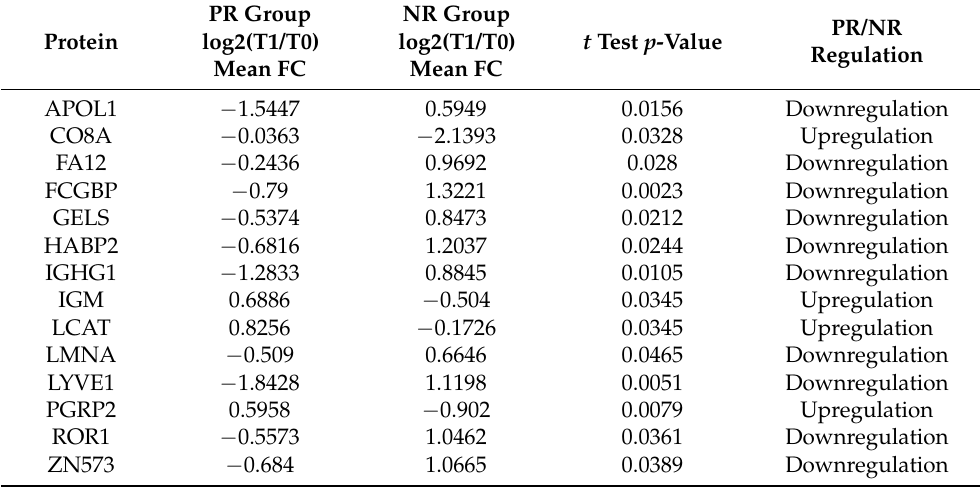
Table 1. Statistically significant DEPs between PR versus NR group at time T0 and T1. Up- or downregulation protein abundance was established by mean of a paired t -test. Statistically significant p -values are reported together with the relative FC (proteins reported in Figure 2a showing p <